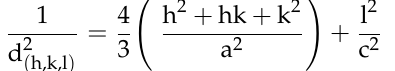
where d h,k,l is the interplanar spacing obtained from Bragg’s law, a and c are the required lattice constants and h, k and l are the Miller indices denoting the plane. Equation (2)